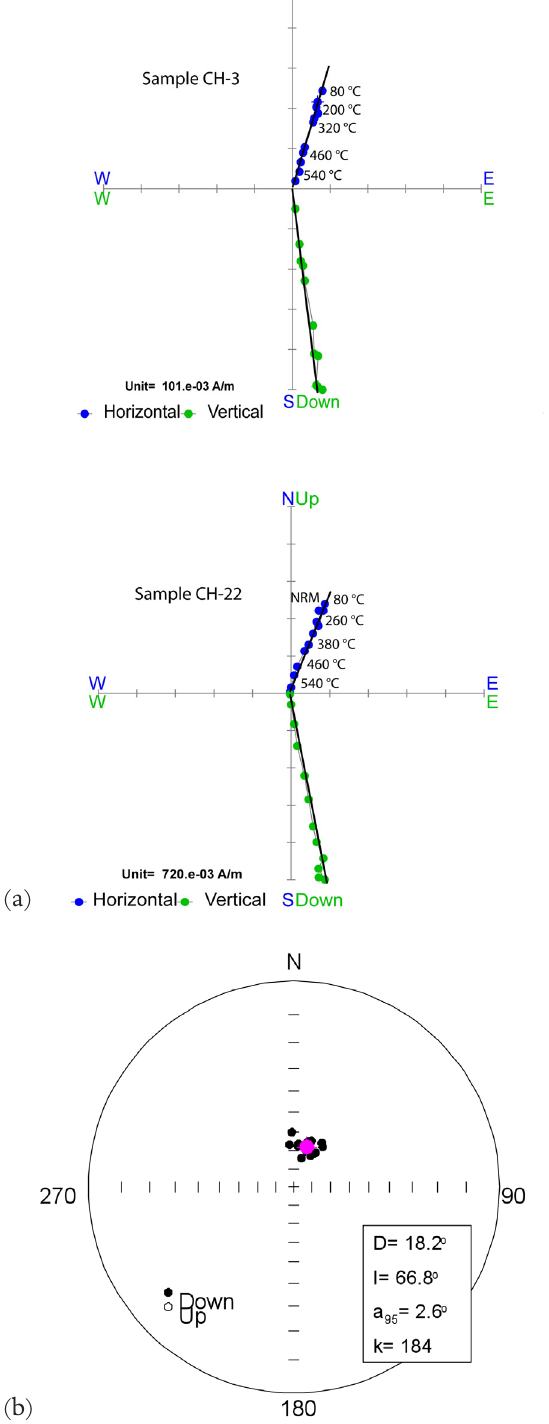
Figure 5 (top and above). (a) Stepwise thermal demagnetization re- sults illustrated as Zijderveld diagrams for representative samples. Sym- bols: full dots = declination; open dots = apparent inclination; (b) Equal area projection of the ChRM directions at sample level together with the kiln’s mean direction as calculated from Fisher statistics (pink Table 1 (right). Archaeomagnetic analysis results. Columns: Sample; Temperature interval used for the calculation of the direction of the ChRM at sample level; Declination (°); Inclination (°); MAD: Maxi- mum Angular Deviation; Mean value: N = number of independently oriented samples; D = mean declination; I = mean inclination; k = m m = 95% semi-angle of confidence. precision parameter; a 95